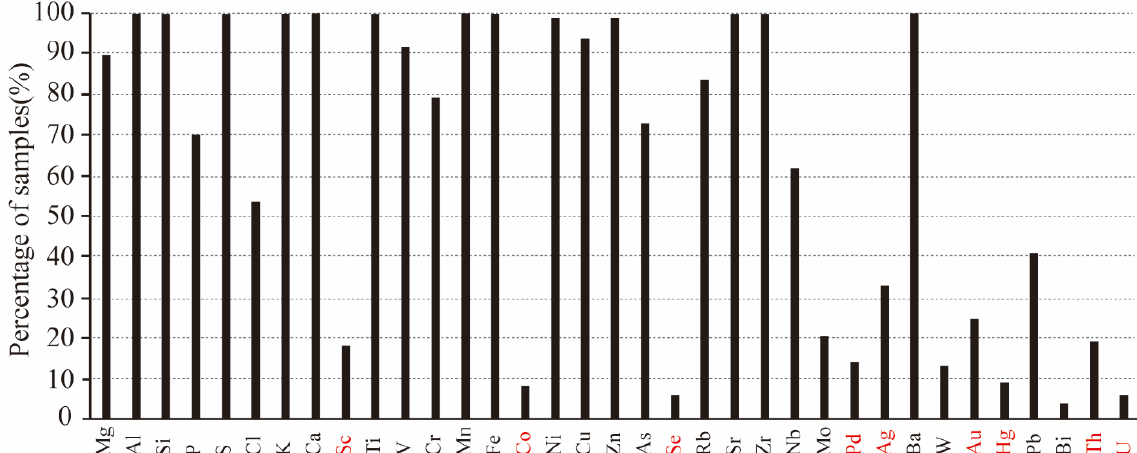
Figure 2. The percentage of rock samples in which an element could be detected by pXRF.